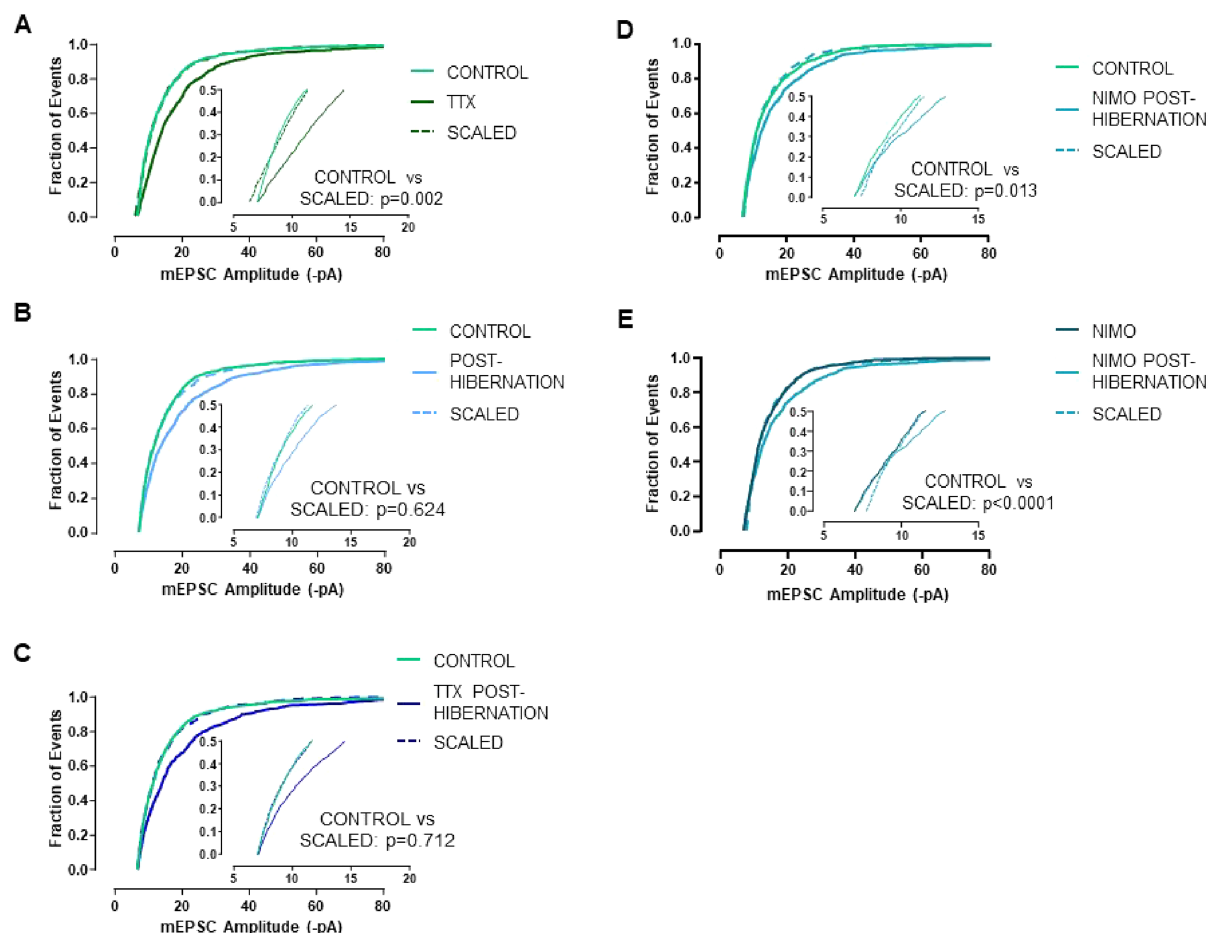
Figure 6. Hibernation, but not TTX, upregulates synaptic strength through multiplicative scaling, and multiplicative scaling is maintained by Ca 2+ feedback. Cumulative distributions of mEPSC amplitudes for time control, treatment (TTX, post-hibernation, post-hibernation + TTX, post-hibernation + nimodipine), and mathematically downscaled treatment distributions. TTX does not lead to apparent multiplicative scaling of mEPSC amplitudes ( A ). Upregulated TTX mEPSCs were downscaled by the linear equation y = 1.47x − 2.21 ( B ) Hibernation and hibernation + TTX increases mEPSCs through multiplicative scaling ( C ). Upregulated hibernation mEPSCs were downscaled by the linear equation y = 1.53x − 3.58 and upregulated mEPSC after hibernation + TTX were downscaled by the equation y = 1.61x − 4.14. ( D , E ) After hibernation in the presence of nimodipine, mEPSC amplitudes were no longer increased according to multiplicative scaling. ( D ) Uses time control as the control group and ( E ) uses the warm-acclimated nimodipine as the control. When using the time control as control, upregulated mEPSC amplitudes after hibernation + nimodipine were downscaled according to the equation, y = 1.45x − 3.76. When using nimodipine from warm acclimated animals as the control, upregulated mEPSCs were downscaled according to the equation y = 1.52 − 4.75. All comparisons between control and treatment yielded p values < 0.0001 (Kolmogorov–Smirnov Test). P-values shown in the figures compare control vs. scaled distributions (Kolmogorov–Smirnov